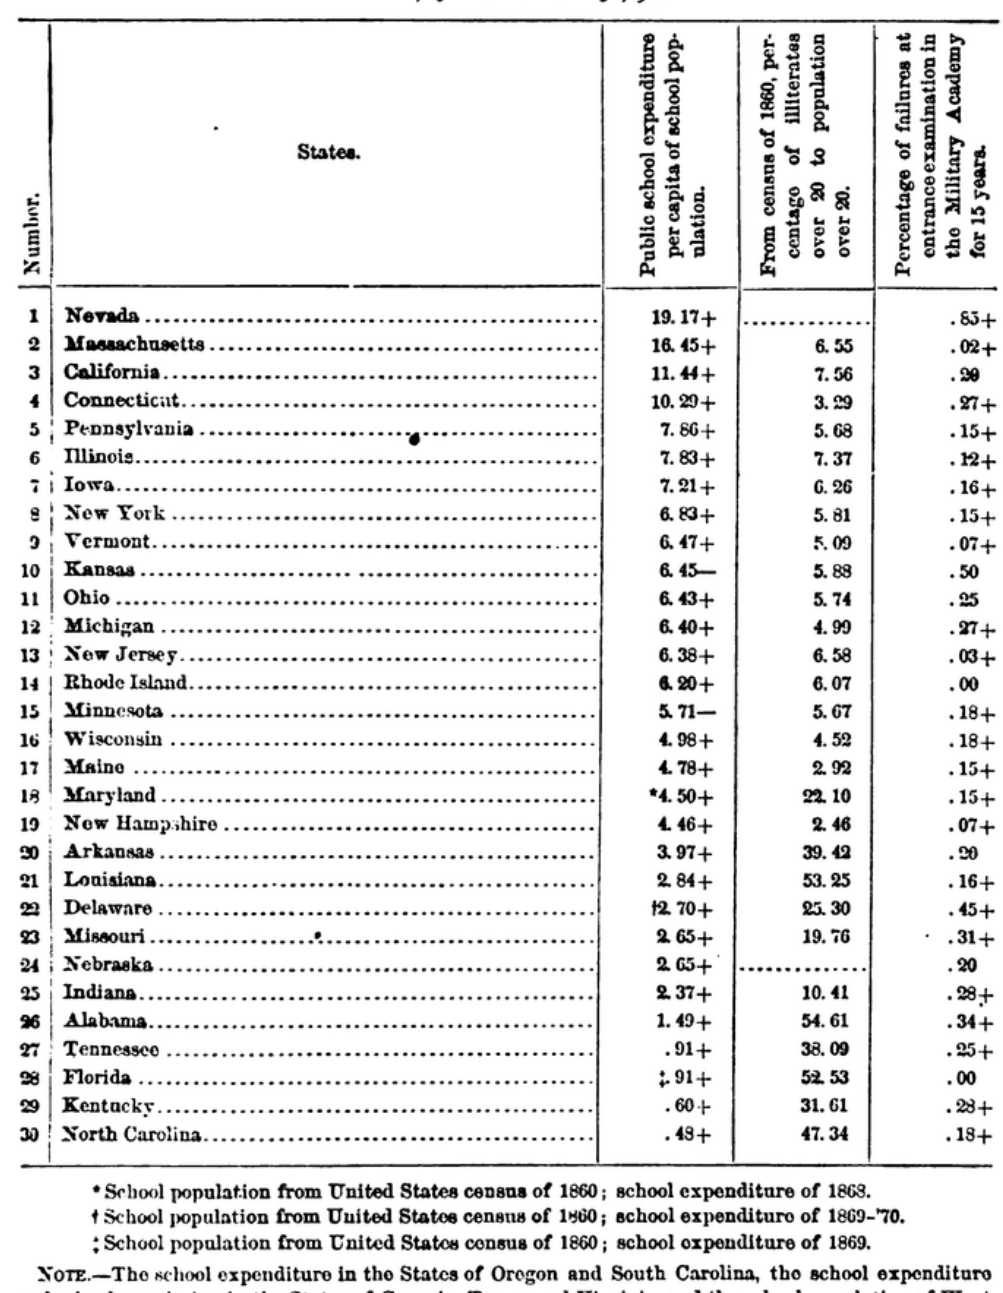
Table 1. Per-School-Age Pupil Spending by State. Eaton sought to harmonize state education spending by presenting disparities. From Eaton